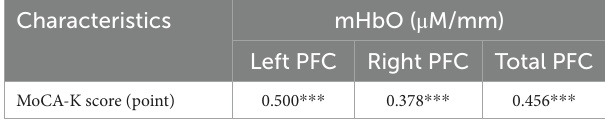
TABLE 5 Correlation the MoCA-K with hemodynamic signals.